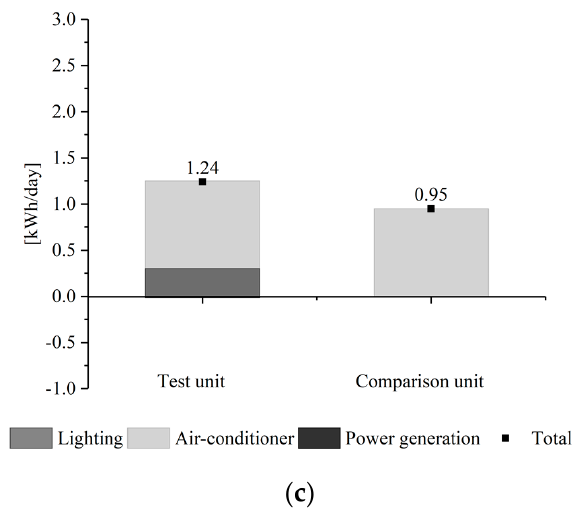
Figure 7. Energy saving analysis for the two units on ( a ) sunny day, ( b ) cloudy to sunny day, and ( c ) a cloudy day.